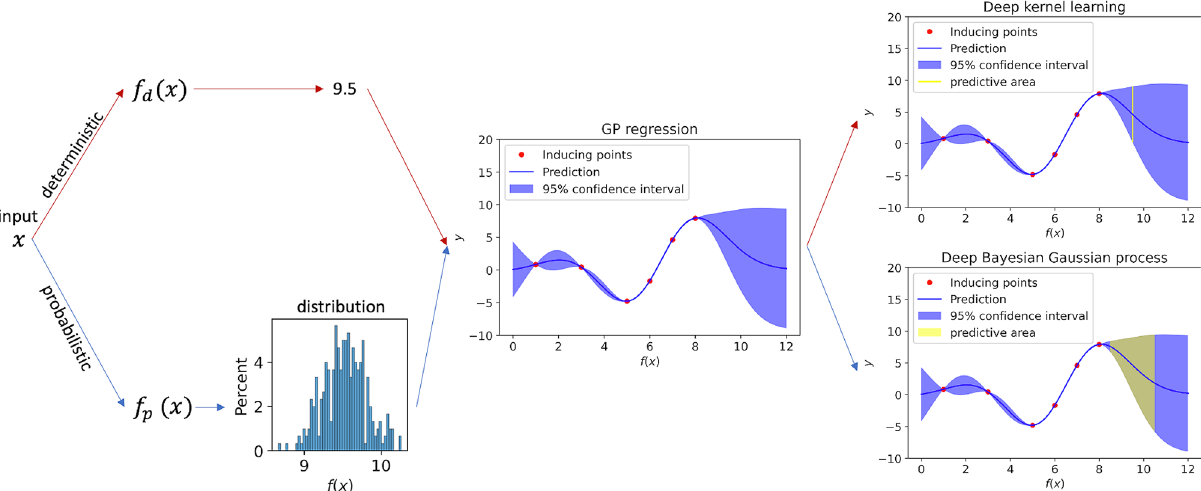
Figure 4. Predictive coverage for DKL and DBGP. The red path and the blue path represent DKL and DBGP, respectively. DKL maps the raw input x to the latent features, which is 9.5 in the figure, using a deterministic model f d . Thus, the GP regressor predicts y for the given f d ( x ) = 9.5 , and the potential prediction y is represented as the yellow line. In contrast, DBGP maps the input x to the latent distribution using a probabilistic model f p , and the GP regressor predicts y conditioned on the latent distribution f p ( x ) . The potential prediction y is represented by the yellow area. Typically, DKL and DBGP make prediction by marginalising the yellow line and the yellow area, respectively. Only one GP regressor is shown here to simplify the description. In practice, both GP regressor and f p or f d are trained